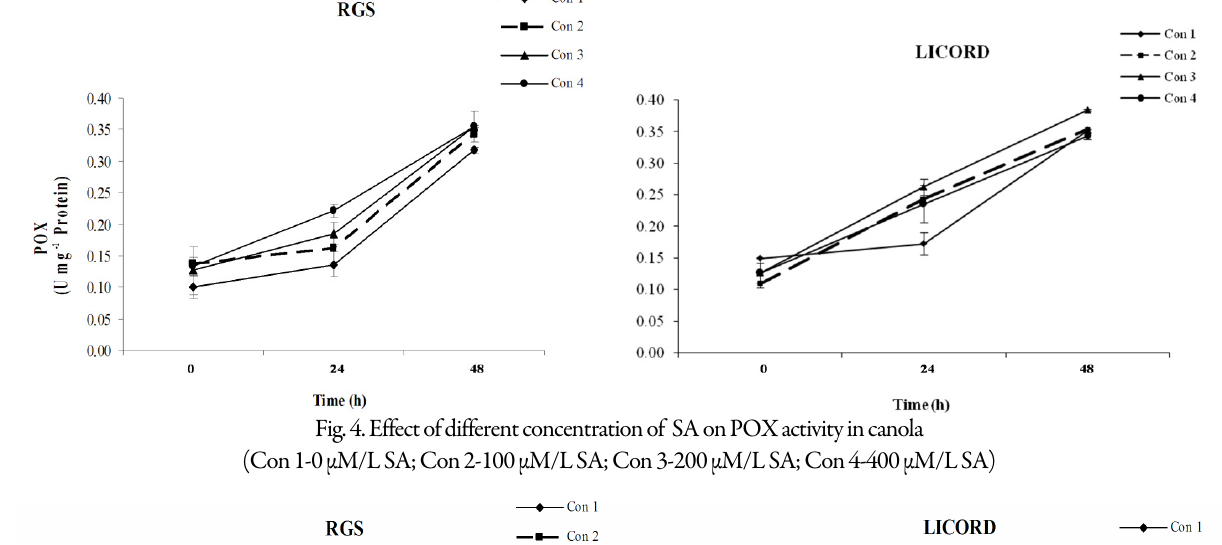
Fig. 4. Effect of different concentration of SA on POX activity in canola